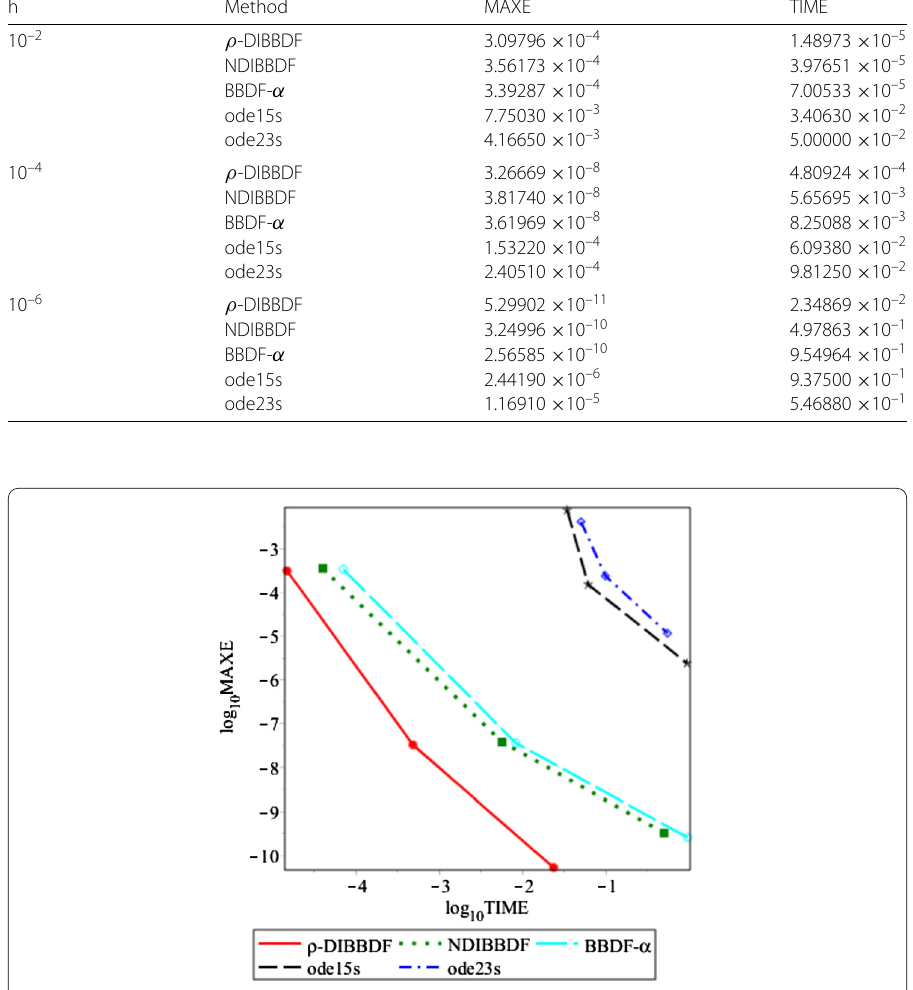
Figure 6 Graph for log 10 MAXE against log 10 TIME of Model A